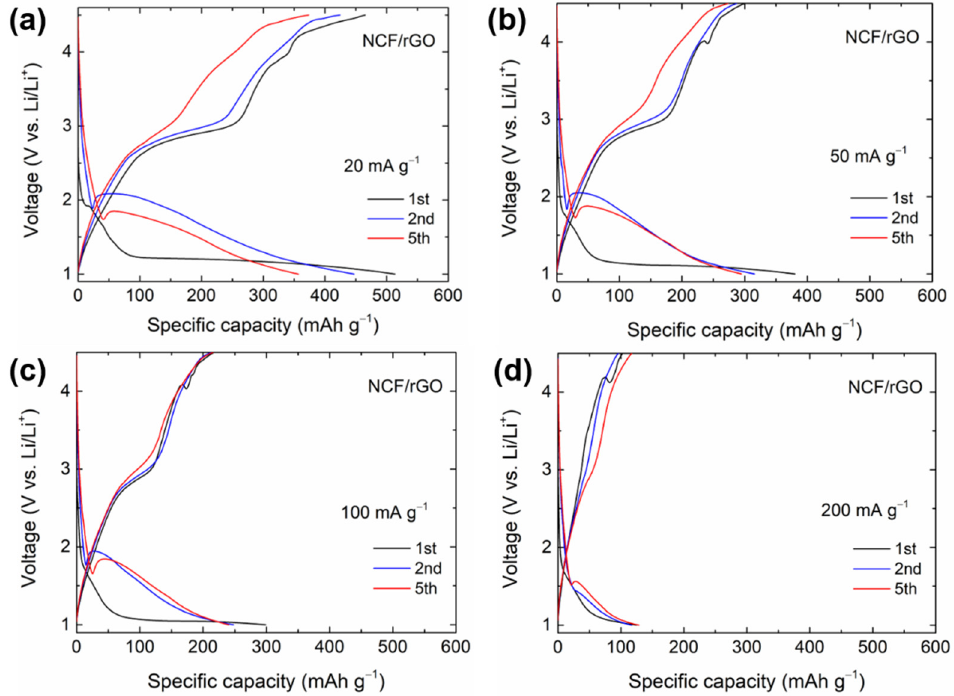
Figure 4. Galvanostatic charge/discharge curves of the 1st, 2nd, and 5th cycles for the NCF/rGO electrode at a current density of ( a ) 20 mA·g − 1 , ( b ) 50 mA·g − 1 , ( c ) 100 mA·g − 1 , and ( d ) 200 mA·g − 1.